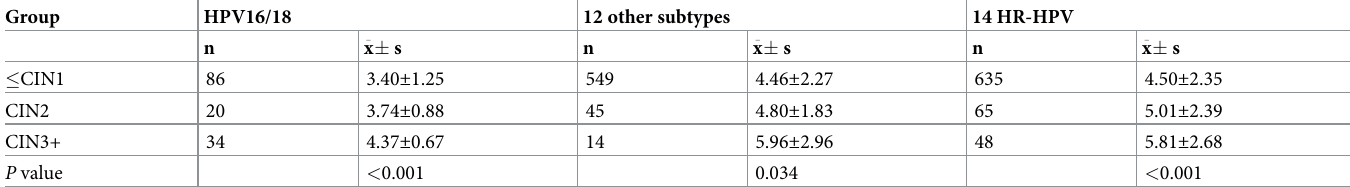
Table 1. Combined 14 HR-HPV, HPV16/18, and 12 other subtypes HR-HPV viral load � relative to the grade of cervical lesion (mean ± standard deviation). Group